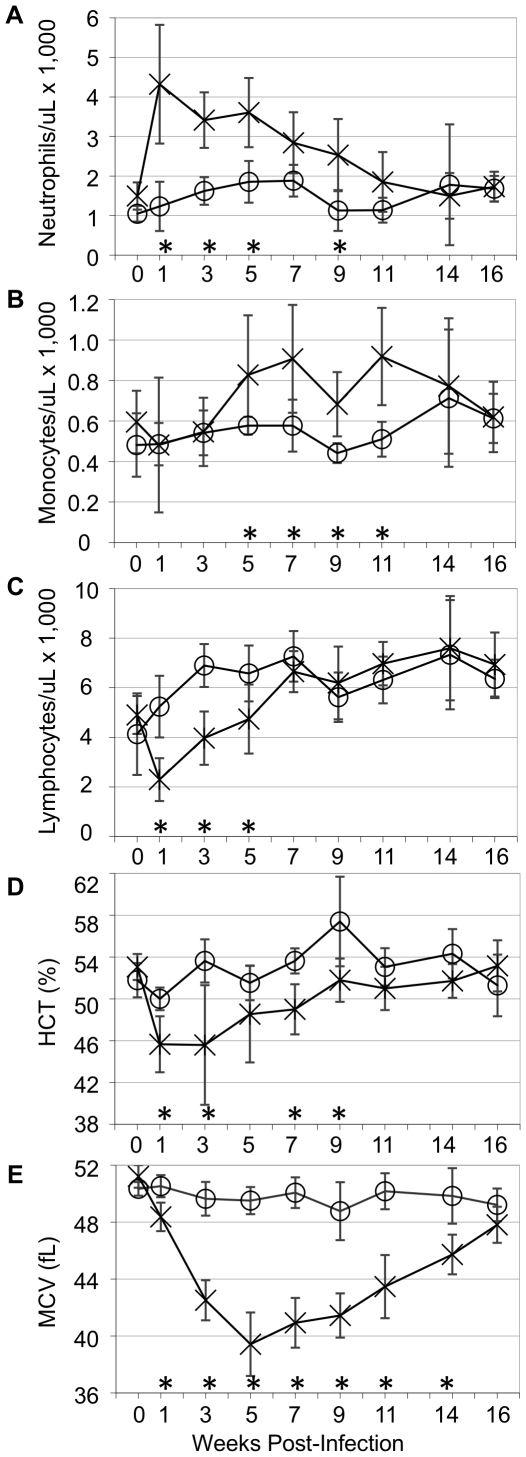
Hematology of S. Typhimurium-infected mice: acute, then chronic active inflammatory response; microcytic anemia, persistent microcytosis.Mice were orally gavaged with 9.1×108 CFU of S. Typhimurium (n = 8) or sterile PBS (n = 7). Complete blood counts were monitored over 16 weeks. X  =  S. Typhimurium-infected mice; circle  =  mock-infected control mice. Mean and standard deviation are shown. (A) neutrophils, (B) monocytes, (C) lymphocytes, (D) hematocrit (HCT), (E) mean cell volume (MCV). *P<0.05 (Student's t-test).